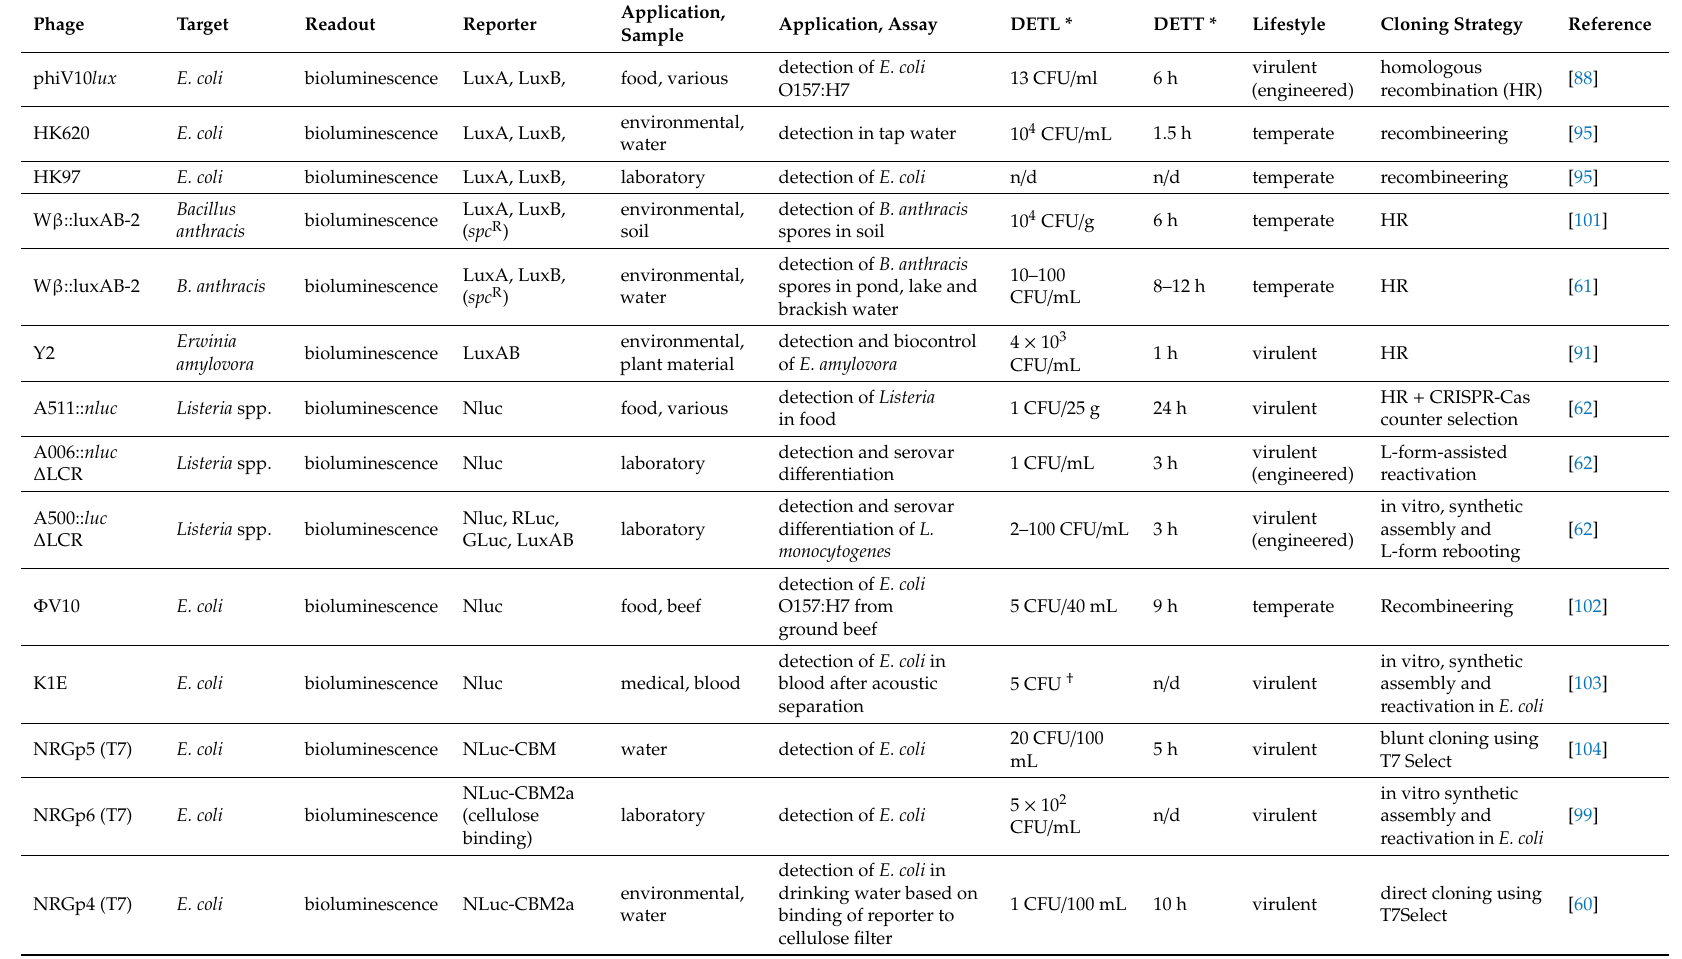
Table 2. Reporter phage-based detection assays published since